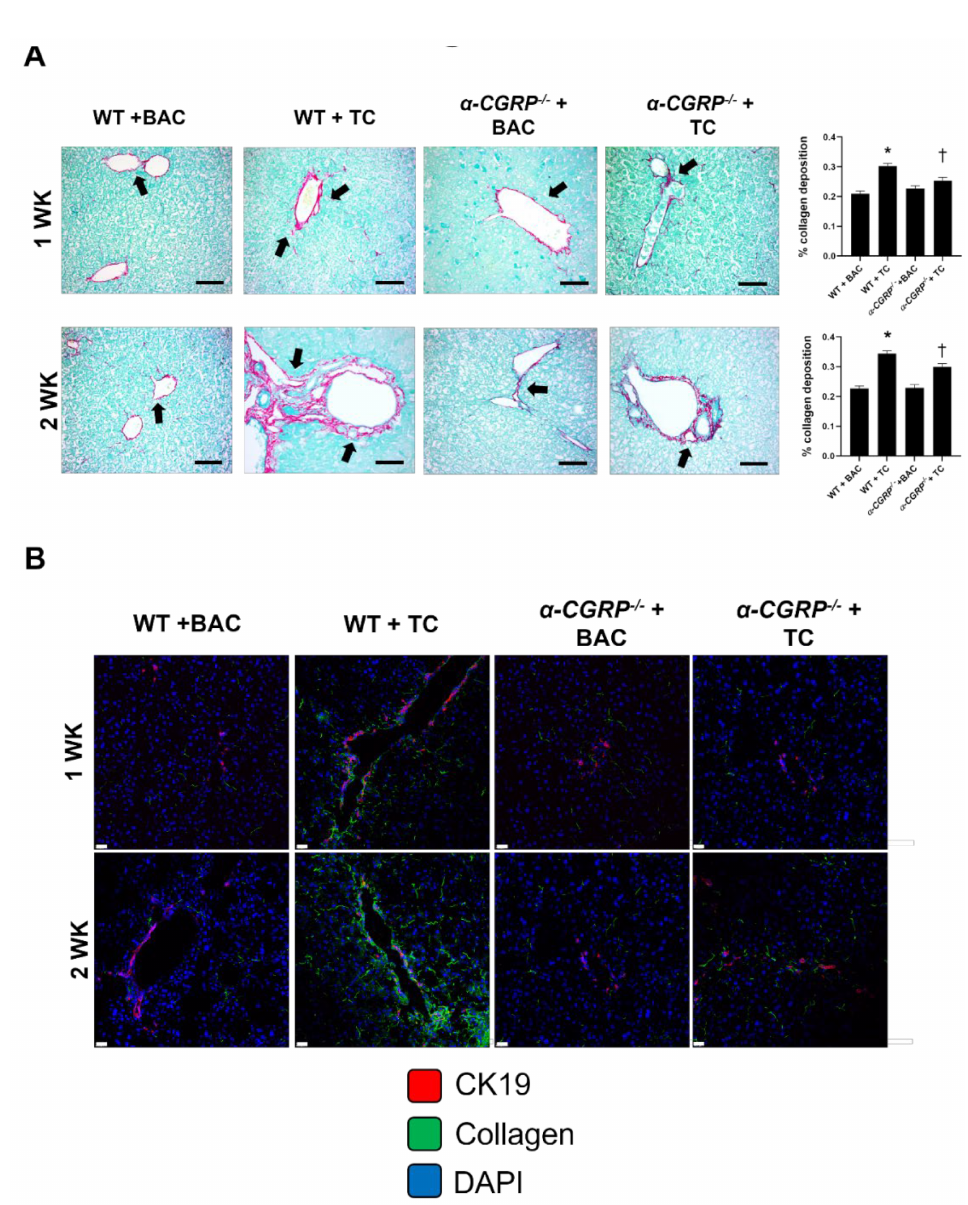
Figure 5. Lack of α -CGRP reduce liver fibrosis in mice fed with TC. ( A ) By Fast Sirius red staining, WT mice treated with TC for 1 or 2 wk showed elevated collagen deposition compared to WT mice treated with BAC, which was significantly reduced in α -CGRP − / − mice fed TC. Original magnification 10 × . Scale Bar 100 µ m. Data are mean ± SEM from n = 6 different animals. * < p value vs. WT + BAC; † < p value vs. WT + TC. ( B ) Immunofluorescence staining shows that TC increased the immunoreactivity of collagen (green) in WT mice. α -CGRP − / − mice fed TC diet have reduced expression of collagen compared to WT-fed TC mice. No significant changes in collagen deposition were observed between normal WT and α -CGRP − / − mice fed BAC diet. Original magnification 20 × ; scale bar 100 µ